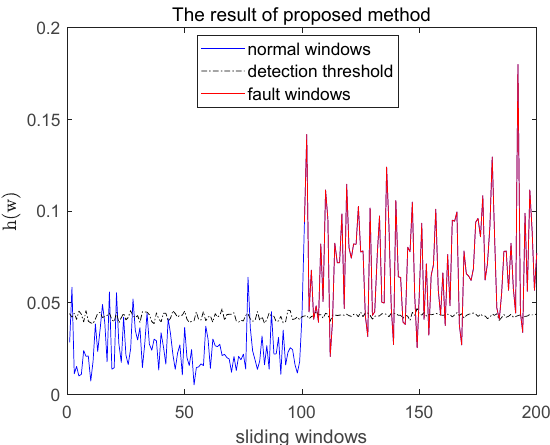
Figure 7. The detection result of the proposed method for the incipient fault f 2 .